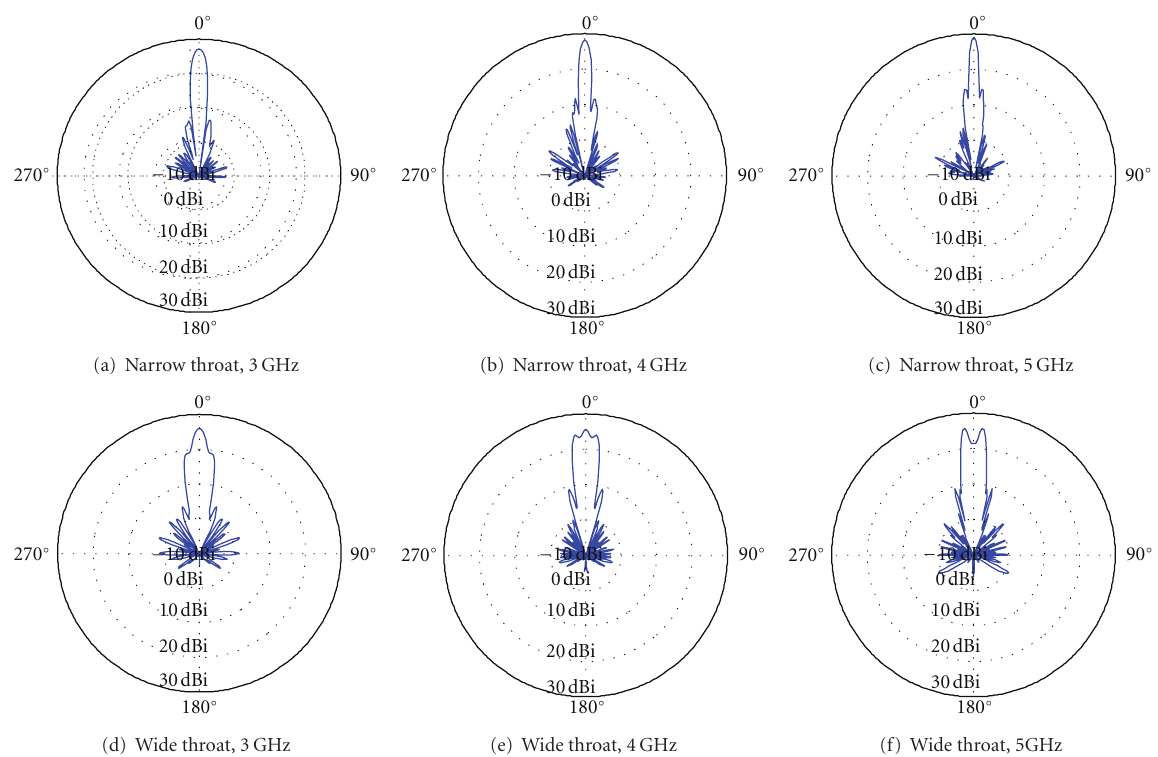
Figure 10: H-plane radiation patterns of the two TEM-wire fed parabolic antennas with a narrow throat-(a), (b), and (c). Those of a wide throat (d), (e), and (f).